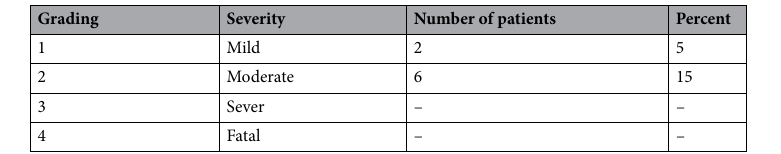
Table 4. The grading of chemotherapeutic drug-induced liver injury in patients with acute lymphoblastic leukemia. Dash (–) denotes absence.